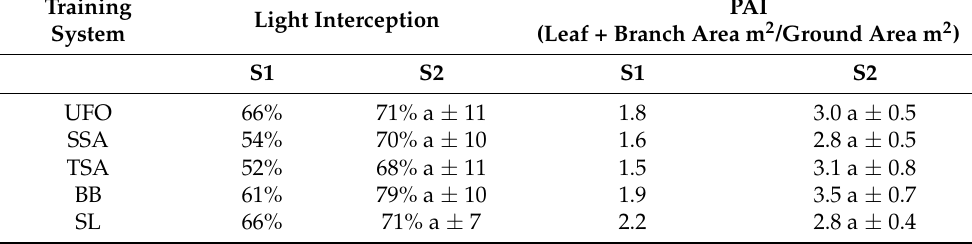
Table 3. Mean light interception and PAI values of the various training systems in the 2019–2020 and 2020–2021 seasons. Letters within columns illustrate significant differences between training systems ( p ≤ 0.05).